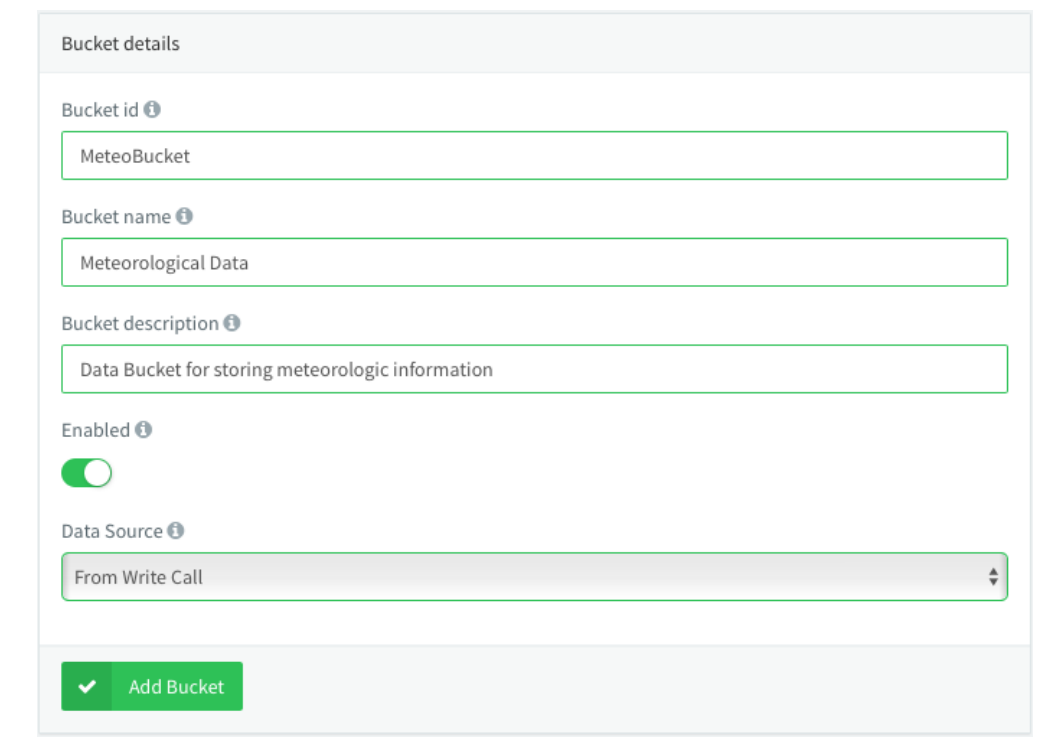
Figure 20. Data bucket configuration in